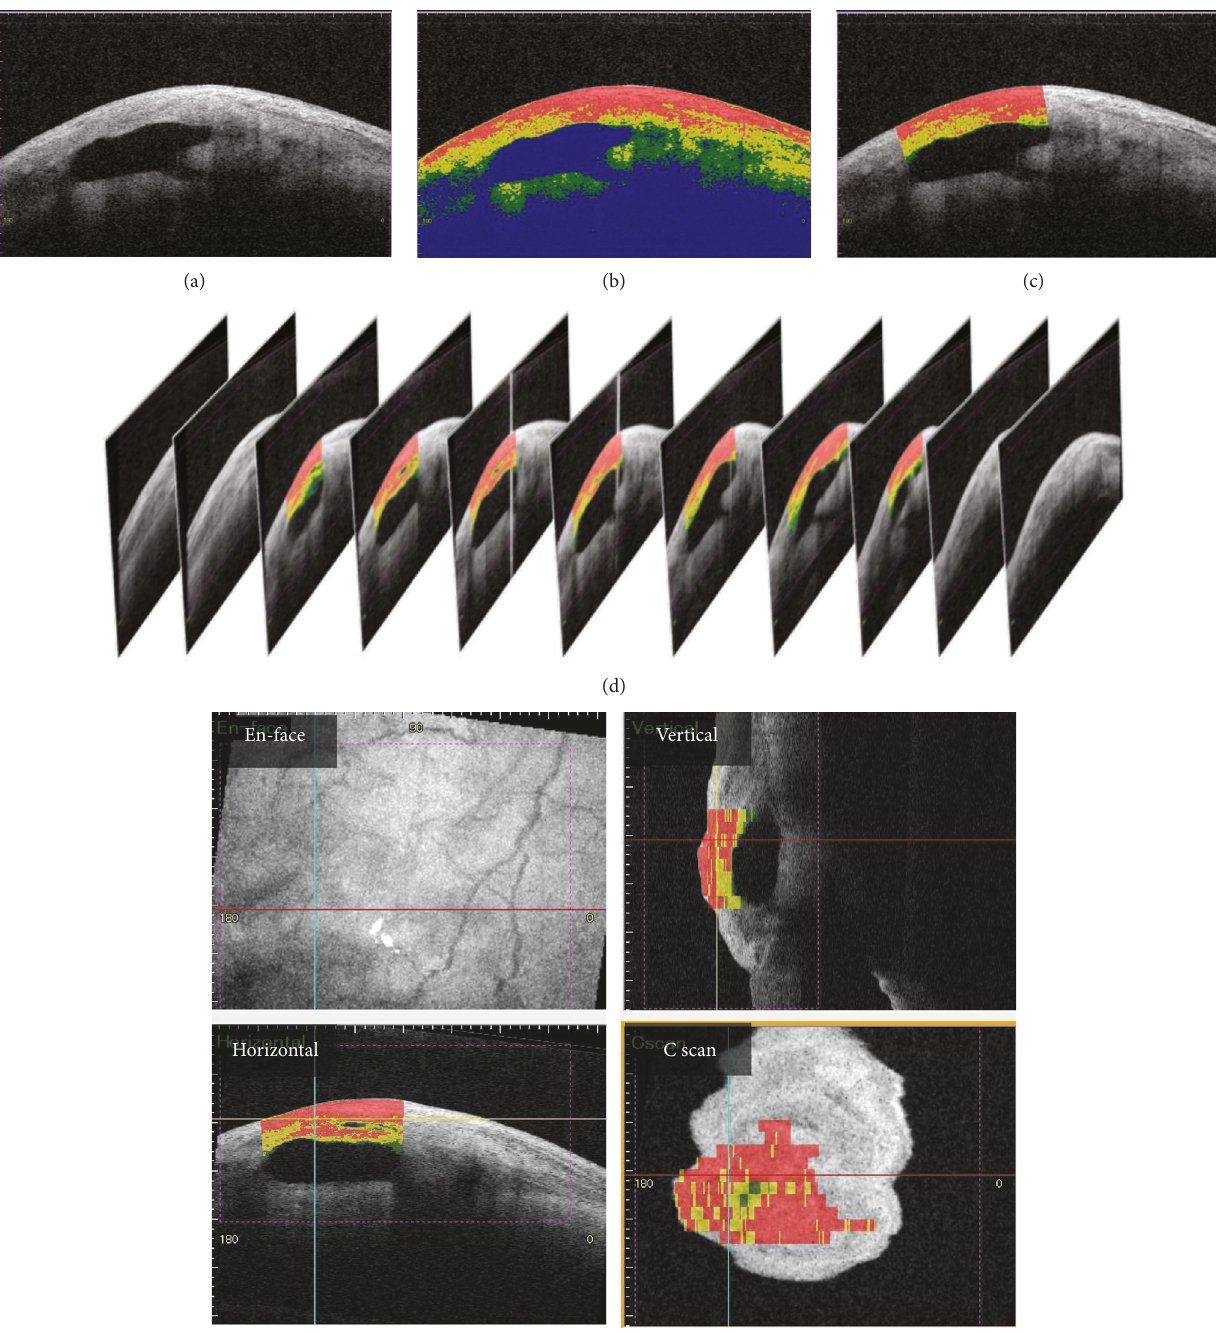
Figure 1: Assessment of bleb wall volume and intensity using 3D AS-OCT. (a) A selected imaging slice from all images of the horizontal raster. (b) A selected imaging slice that was automatically color-coded into four categories based on the optical density: (1) high intensity (red; optical density, 150 – 255); (2) medium intensity (yellow; optical density, 100 – 149); (3) low intensity (green; optical density, 50 – 99); and (4) fl uid cavity (blue; optical density, 0 – 49), using built-in software. (c) A selected imaging slice with color code only in the bleb wall, which was de fi ned to be subjected to analysis by manually drawing lines perpendicular to the scleral fl ap at the edges of the fl uid cavity. (d) Schematic image of the three-dimensional reconstruction of the selected imaging slices after color-coding and bleb wall de fi nition. (e) En-face, vertical, horizontal, and C-scan images after reconstruction with color code in the bleb wall. The red and blue lines indicate the horizontal and vertical axes, respectively. The yellow line represents the z -axis of the C-scan images. The volumes of each color-coded category were automatically calculated by reconstructive accumulation of the two-dimensional images, using the built-in